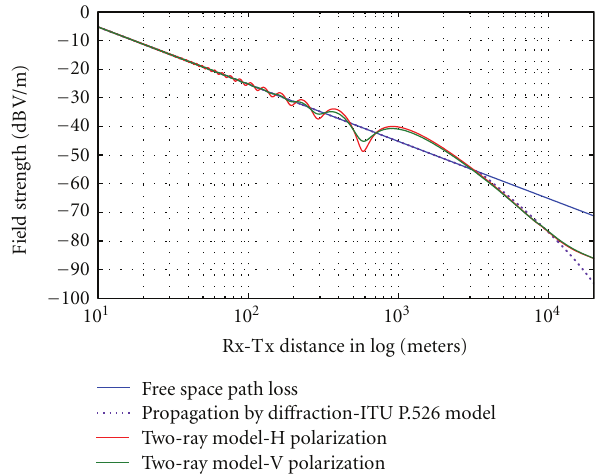
Figure 3: Field strength (dB V/m) versus distance (log scale), sea state 3 on Douglas scale.